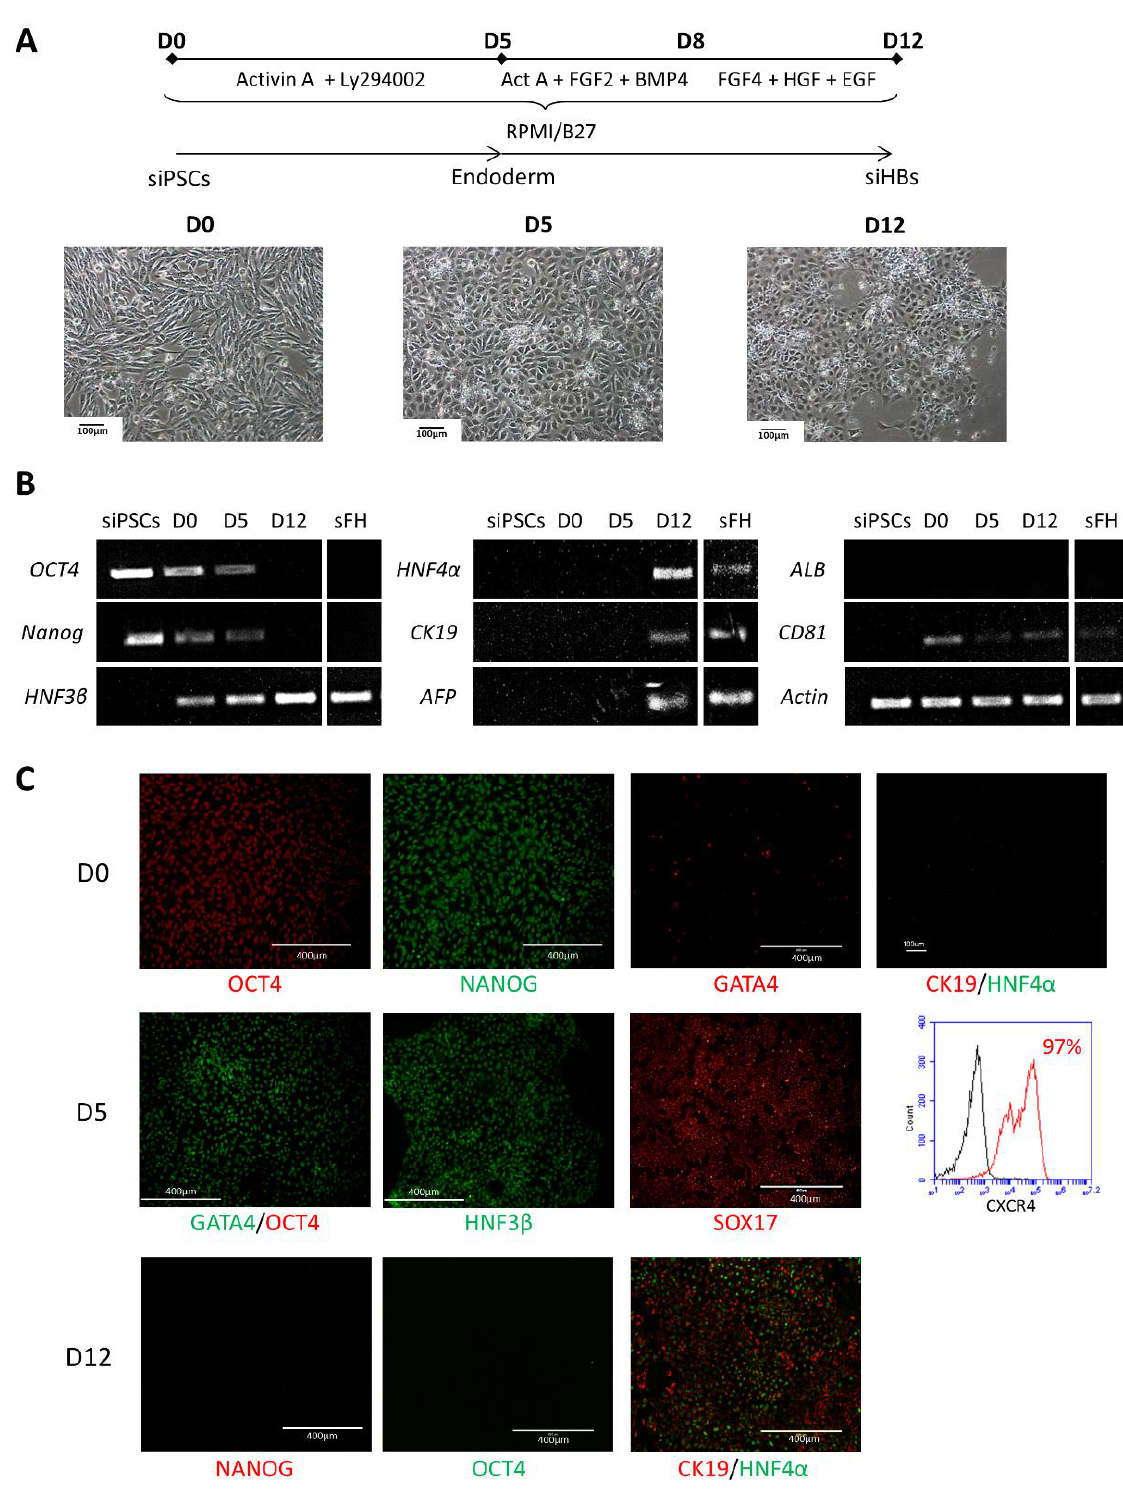
Figure 1. Hepatoblast differentiation of siPSCs. ( A ) Schematic representation of the protocol and phase contrast images illustrating the evolution of cell morphology. ( B ) RT-PCR showing modifica- tions to the gene expression pattern during siPSC differentiation into siHBs. ( C ) Immunostaining and flow cytometry analyses showing the expression of OCT4 and NANOG stem cell markers, the definitive endoderm markers GATA4, HNF3 β and CXCR4, and HNF4 α and CK19 hepatoblast markers during siPSC differentiation. sFH: simian fetal hepatocytes.